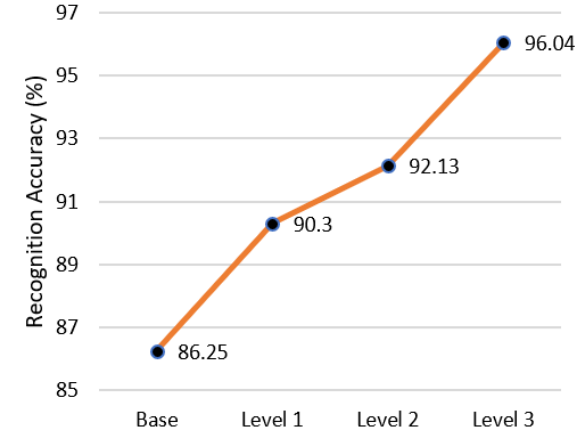
Figure 17. Graphical representation of individual modules contribution for every targeted country.